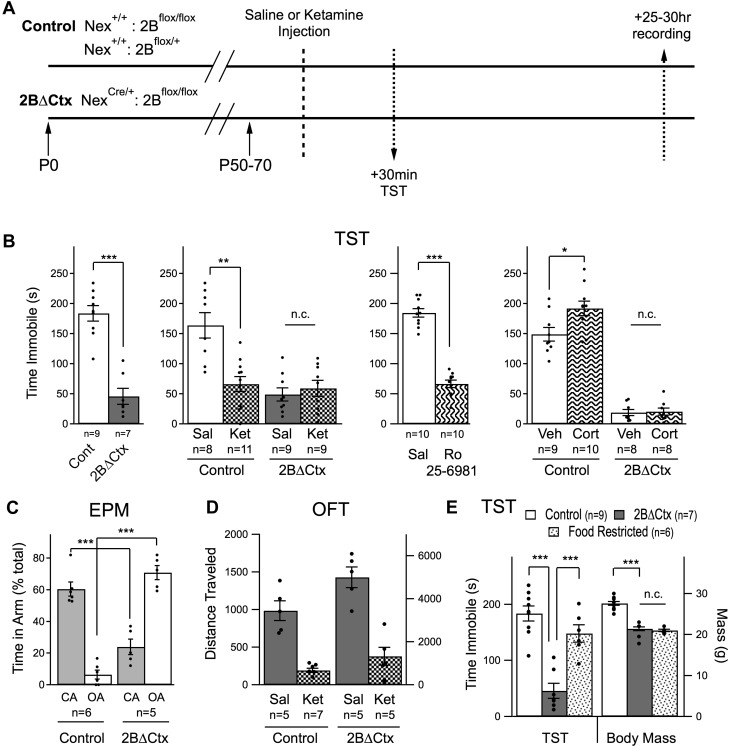
Decreased despair-like behavior and occlusion of ketamine's actions in 2BΔCtx animals.(A) Experimental timeline: male animals between P50 and P70 were subjected to i.p. ketamine injection (ket) or saline control injection (sal). 30 min following injection, animals were analyzed in the tail suspension test (TST). At 25–30 hr post-injection, animals were subjected to electrophysiological analysis (see Figure 3). (B) A significant decrease in immobility scores was measured in 2BΔCtx animals in the TST and this was mimicked by treatment with the GluN2B-containing NMDAR selective antagonist Ro 25–6981. The decrease in immobility scores in the 2BΔCtx animals occluded effect of ketamine injection seen in littermate control animals. 2BΔCtx animals were also insensitive to chronic corticosterone treatment (Cort), while this same treatment increased immobility times in TST in control, corticosterone-treated animals. (C) 2BΔCtx exhibited a strong anxiolytic behavioral phenotype compared to control animals as measured in the elevated plus maze (EPM). (D) Measuring total distance traveled in the open field test (OFT) showed a strong and significant effect of ketamine in both genotypes, suggesting that the decreased immobility time in 2BΔCtx animals was not simply due to hyperlocomotion. (E) Food restriction was also used in control animals to demonstrate that the decreased immobility times in 2BΔCtx animals was not a consequence of decreased body mass. Data values are means ± sem. *p < 0.05; **p < 0.01; ***p < 0.001 t test with respect to control; n.c. = no significant change.